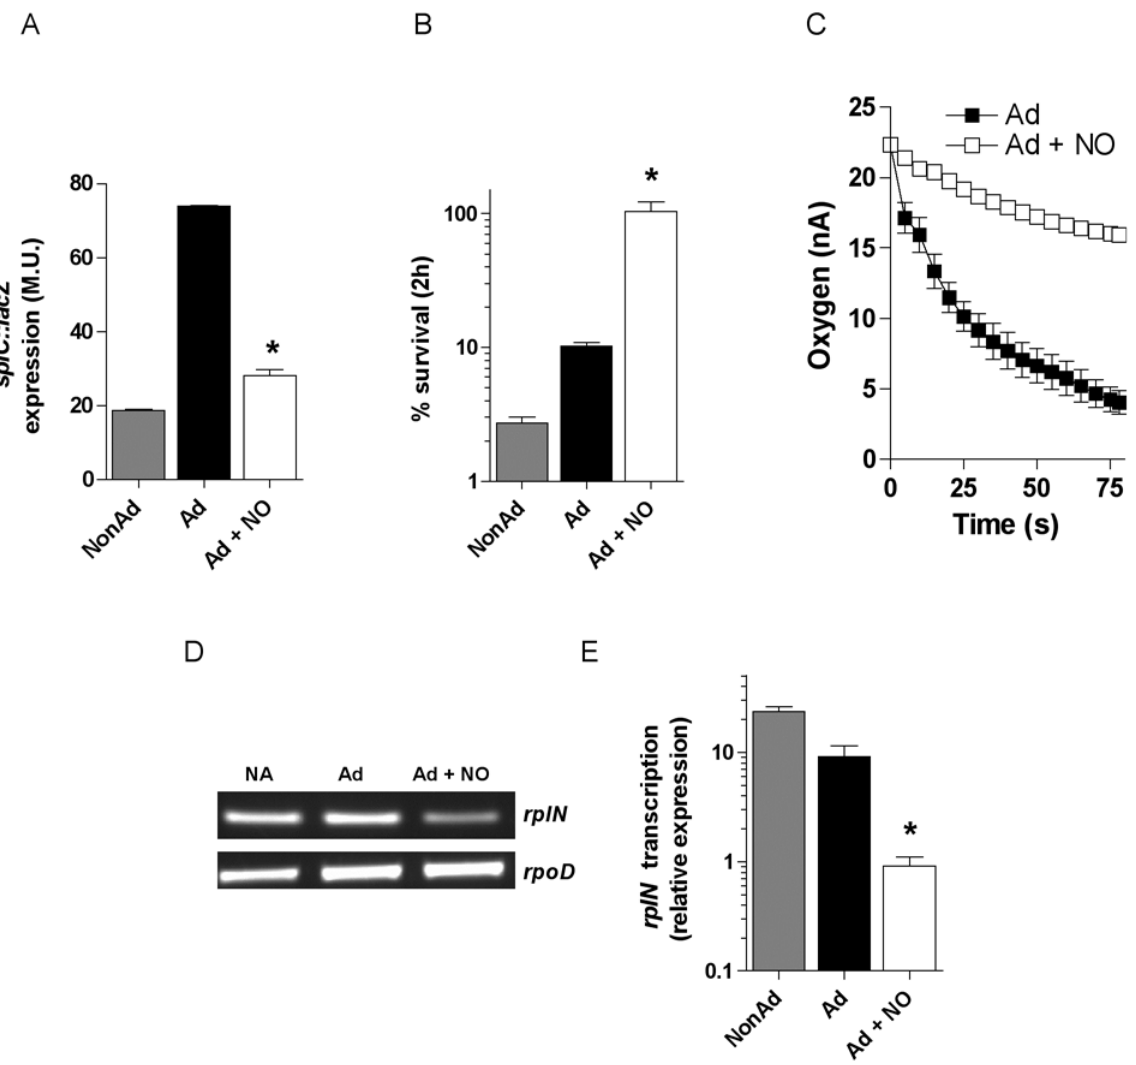
Figure 4. Responses of Salmonella to acidified RNS. The acid-inducible expression of the SPI2-encoded spiC::lacZ transcriptional fusion was compared in nonadapted (NonAd), adapted (Ad) and adapted + 250 m M spermine NONOate (Ad + NO) Salmonella cultures (A). The survival of NonAd, Ad and Ad + NO Salmonella cultures exposed for 1 h to 400 m M H 2 O 2 in PBS is shown in panel B. Oxygen consumption was monitored in Ad and Ad + NO Salmonella cultures (C). The transcription of the ribosomal protein-encoding gene rplN relative to the housekeeping gene rpoD was monitored by semi-quantitative (D) and quantitative RT-PCR (E). Relative expression is represented as the ratio of rplN/rpoD transcripts. Data represent the mean 6 SEM of 3–6 independent observations. *, p , 0.05 by one-way